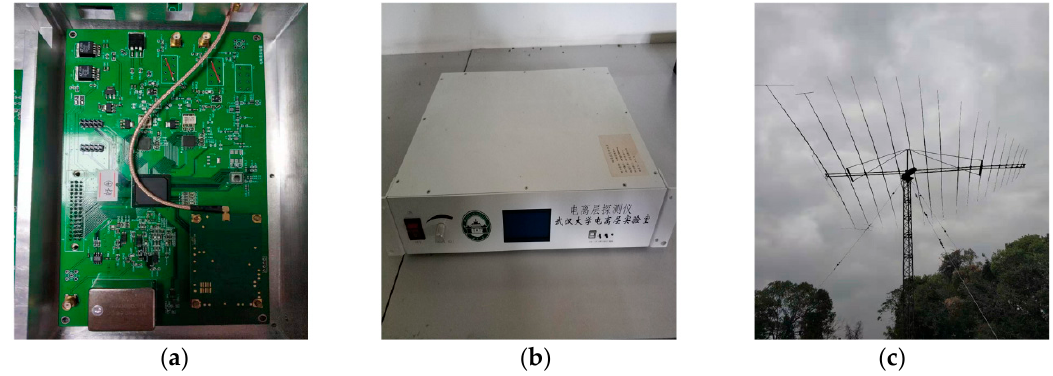
Figure 2. ( a ) The transmitting channel; ( b ) the power amplifier; ( c ) the transmitting antenna.